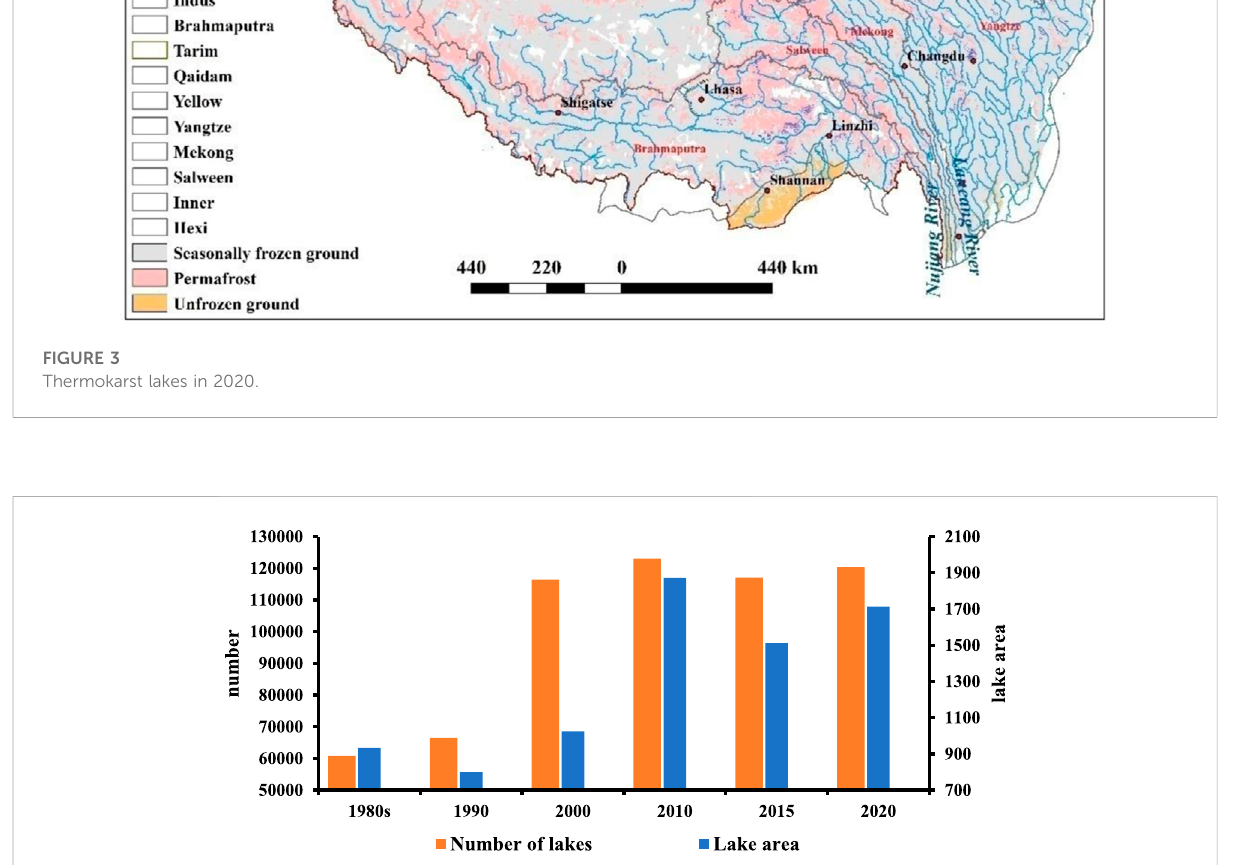
FIGURE 4 Number and area of thermokarst lakes in QTP, 1980s –